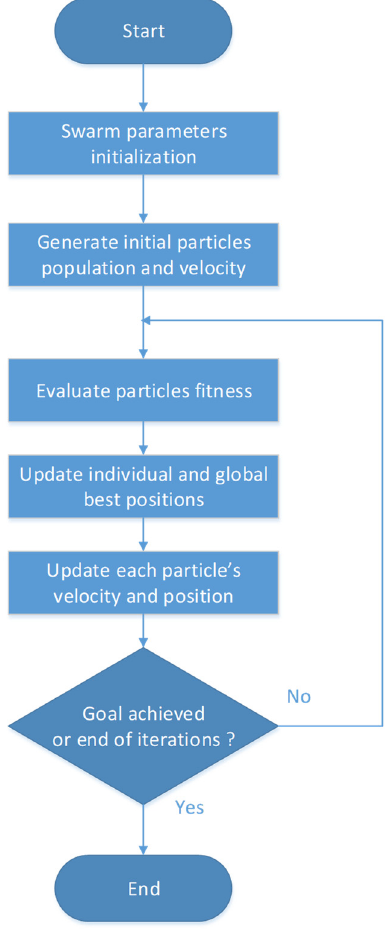
Figure 1. Simplified flowchart of PSO algorithm.